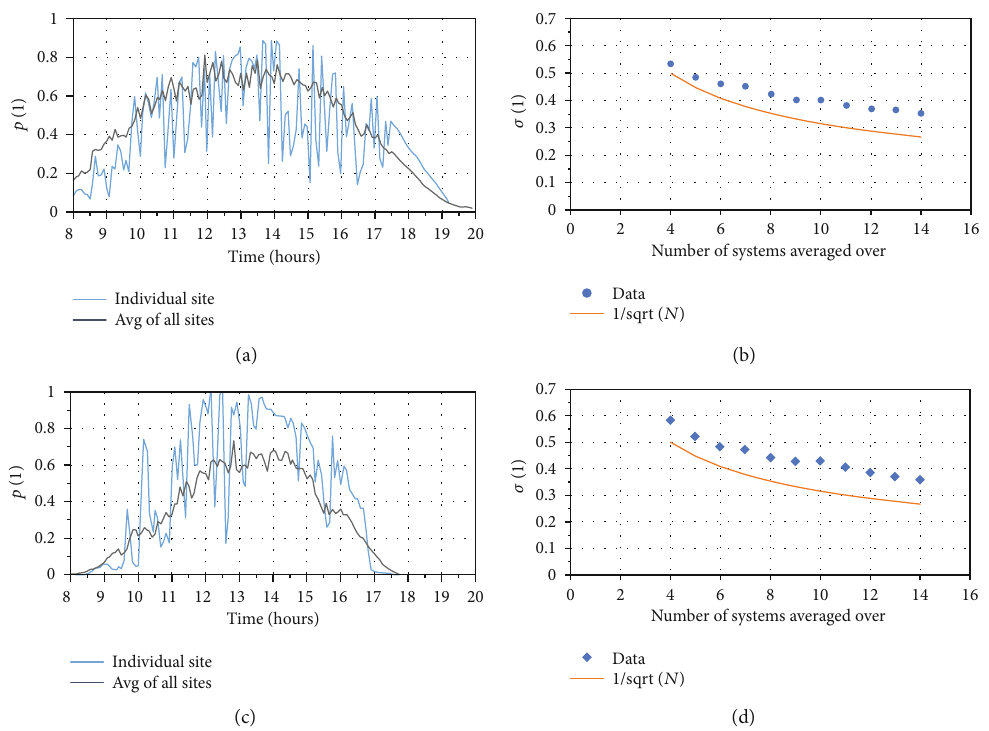
P P Figure 9: Smoothing of solar output, p n / s , due to geographic dispersion of systems on days of high solar variability in spring/summer n = and fall/winter months: (a) normalized production of a single system (blue) and the average of 14 systems (gray) on July 26, 2016; (b) reduction in the variance of solar ramp rates, σ = σ / σ , in spring/summer as a function of the number of systems over which avg 1, N averaging takes place; (c) normalized production of a single system and the average of 14 systems on November 4, 2016; (d) reduction in the variance of solar ramp rates in fall/winter as a function of the number of systems averaged